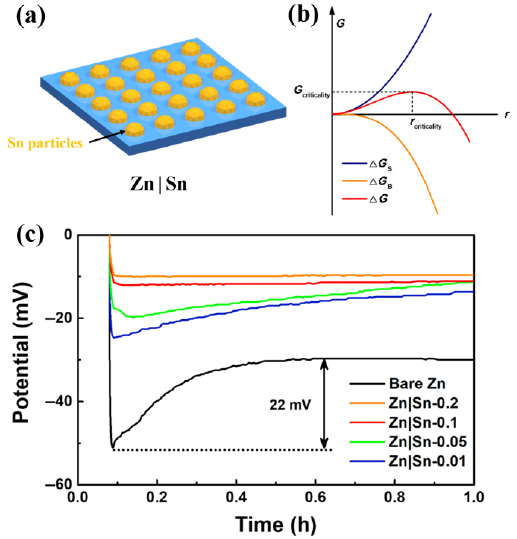
Figure 3 (a) Schematic diagram of Sn crystal nuclei on the Zn|Sn anode. (b) Free energy change of the proposed nucleation during Zn plating process. (c) Nucleation overpotentials of Zn|Sn- X and the bare Zn electrode at a current density of 1 mA·cm −2 .